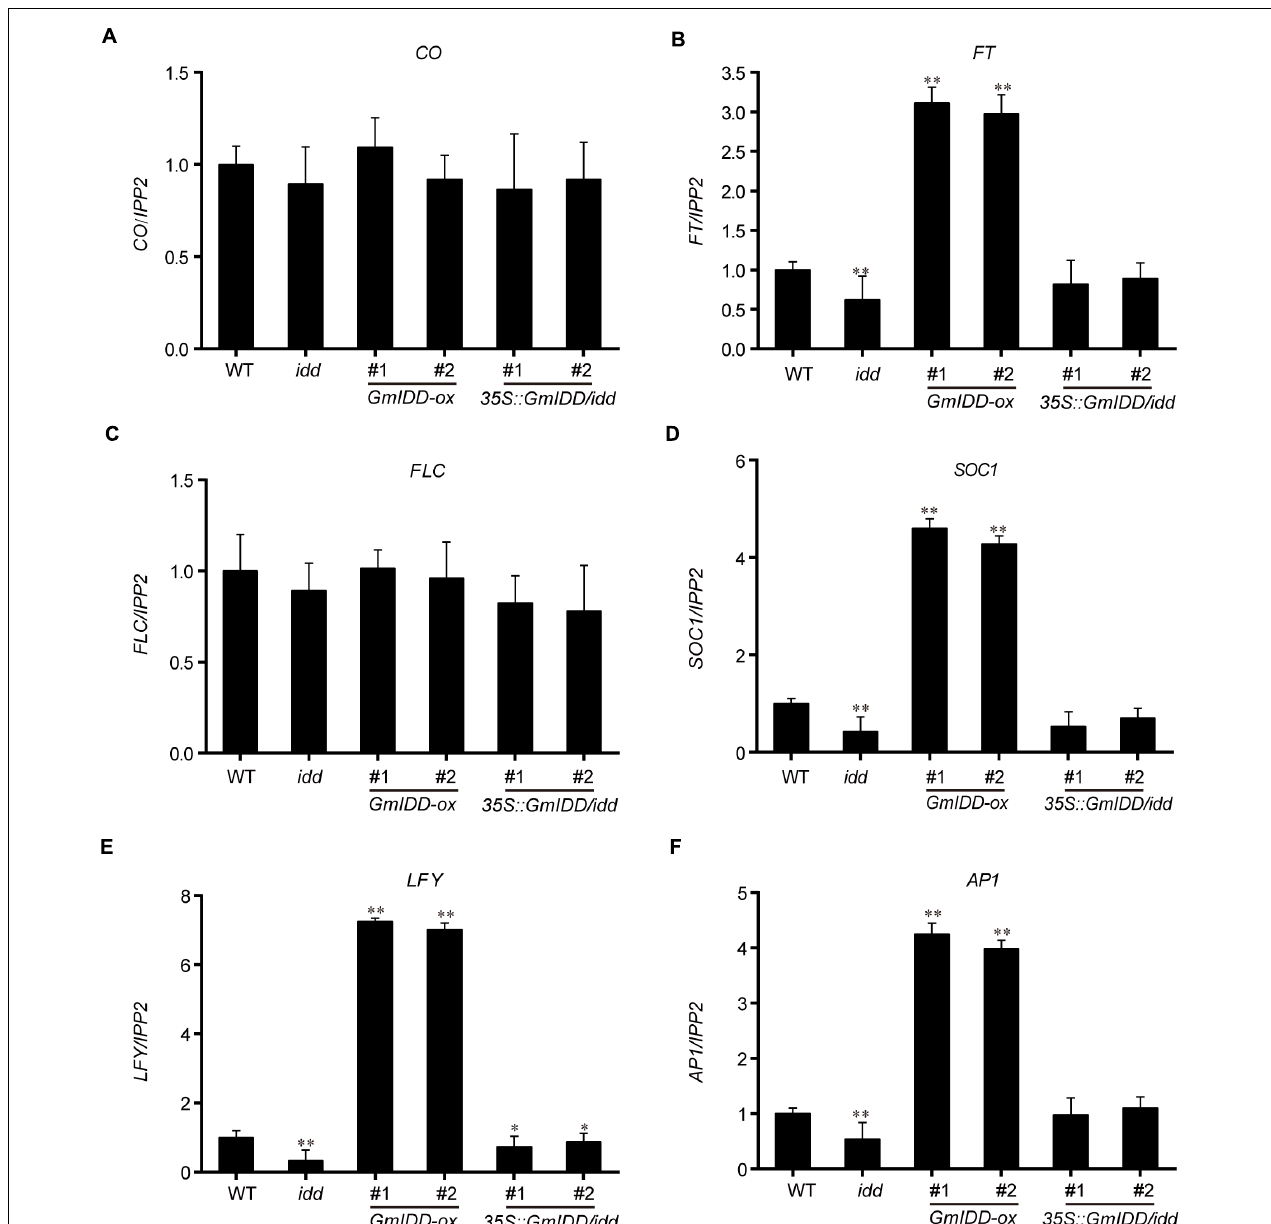
FIGURE 5 | Expression levels of flowering time-related genes in GmIDD-ox , idd mutants, 35S:GmIDD/idd restoration and WT Arabidopsis plants were investigated by qRT-PCR. WT and GmIDD -transgenic plants were cultured in LDs for 15 days, and sampled 12 h after dawn for qRT-PCR analysis the expression levels of flowering time-related genes to determine the mechanism of GmIDD regulating flowering time. (A–F) Relative expression of the CO , FT , FLC , SOC1 , LFY, and AP1 , respectively. For each experiment, three technical replicates were conducted. Data shown are mean ± SD of three independent experiments, the significant differences between GmIDD -transgenic and WT plants are indicated by asterisks ( ∗ P < 0.05 and ∗∗ P < 0.01, Student’s t